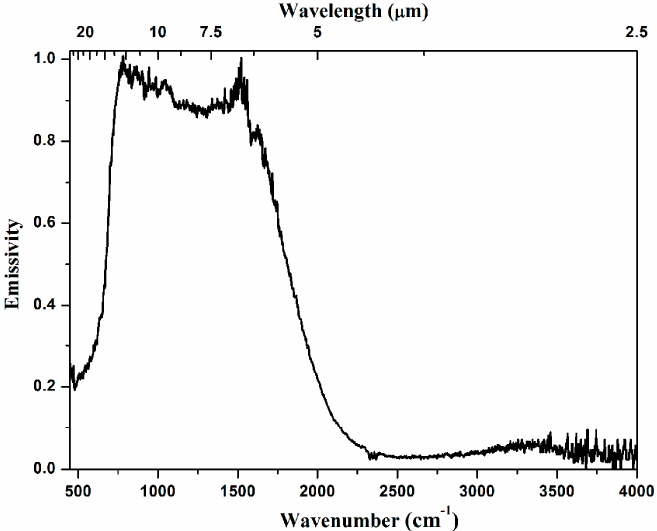
Figure 8. The emittance of a 3Y-TZP sample (25.4 mm diameter, 3.0 mm thick) at 427 °C.